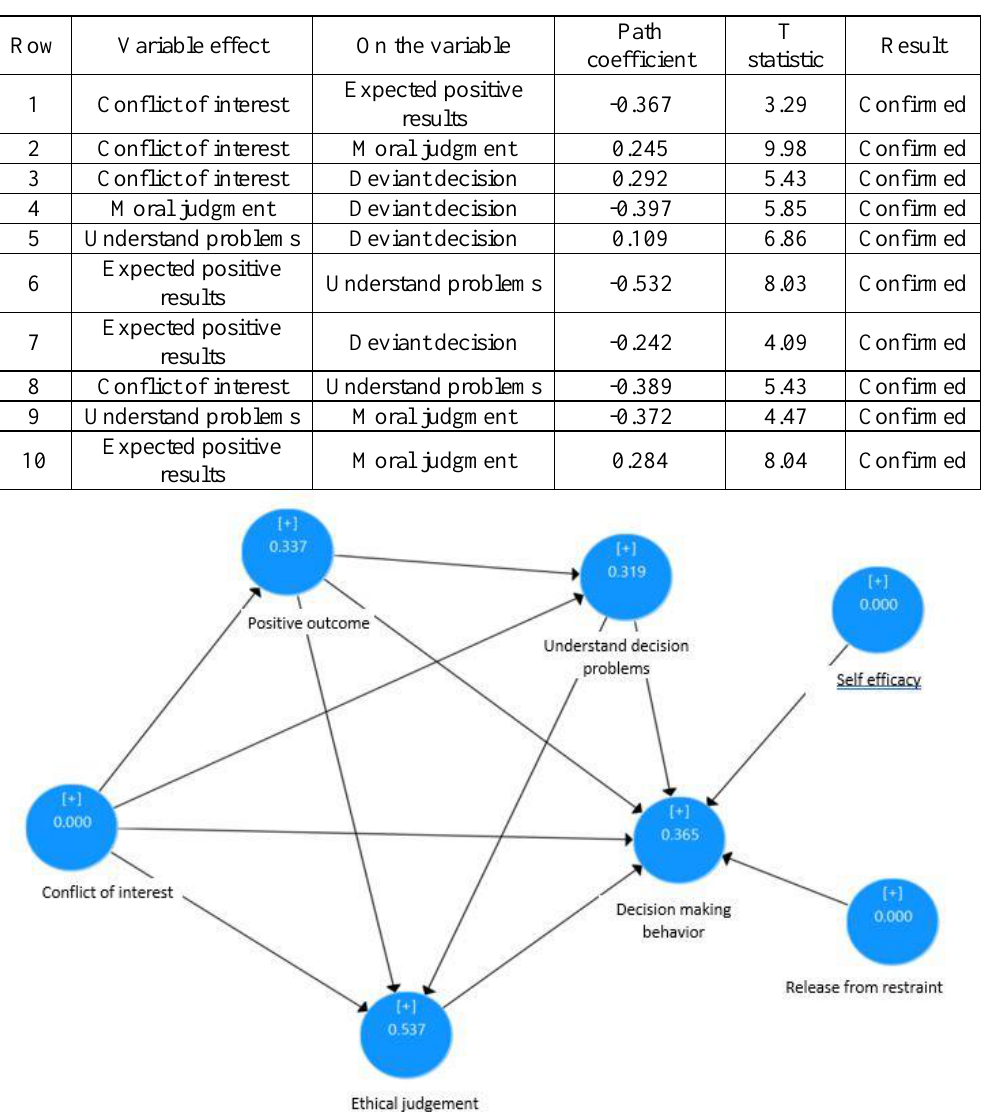
Table 6. T-statistic values for research variables